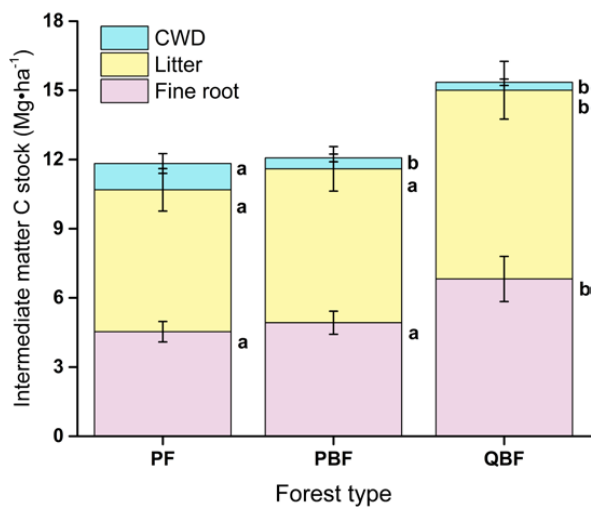
Figure 3. The intermediate matter carbon stocks in the pure Pinus tabuliformis forest (PF), Figure 3. Theintermediatemattercarbonstocksinthepure Pinustabuliformis forest(PF),pine-broadleaved pine-broadleaved mixed forest (PBF) and Quercus -broadleaved mixed forest (QBF) in the mixed forest (PBF) and Quercus -broadleaved mixed forest (QBF) in the central Loess Plateau of China. central Loess Plateau of China. a and b indicate significant differences in the carbon stocks of a and b indicate significant differences in the carbon stocks of the same components at different succession the same components at different succession stages at p = 0.05. stages at p = 0.05.